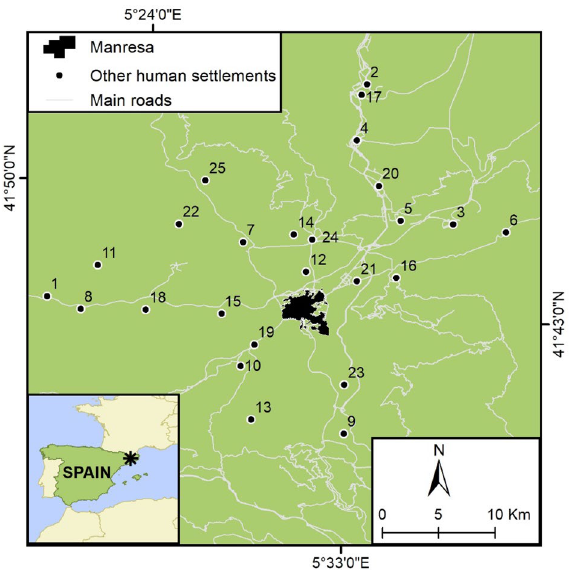
Figure 1. Geographic location of the studied human settlements. The numbers correspond to those indicated in Table 1. This figure was drawn using ArcGIS [GIS software] Version 10.8.0.12790 (http:// www. esri.